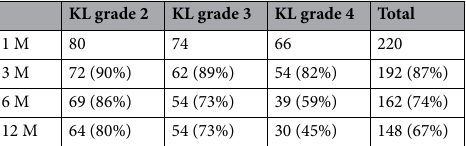
Table 2. Number of followed up knees and rates relative to the baseline. KL